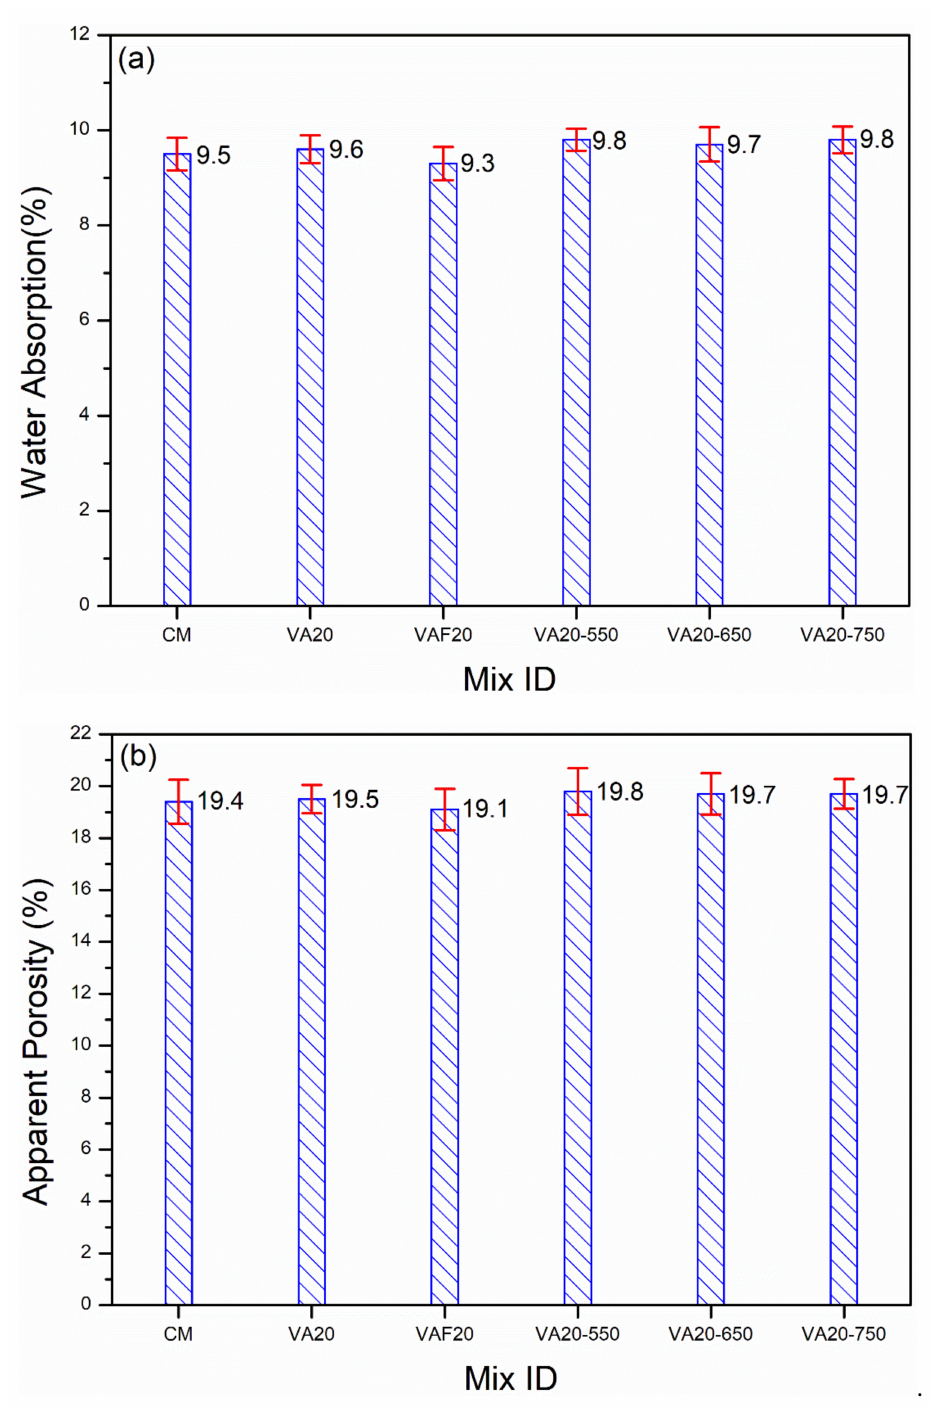
Figure 8. Comparison of ( a ) water absorption, ( b ) apparent porosity results between control, and mortar containing VAF, and heat-treated and untreated VA after 91 days of standard